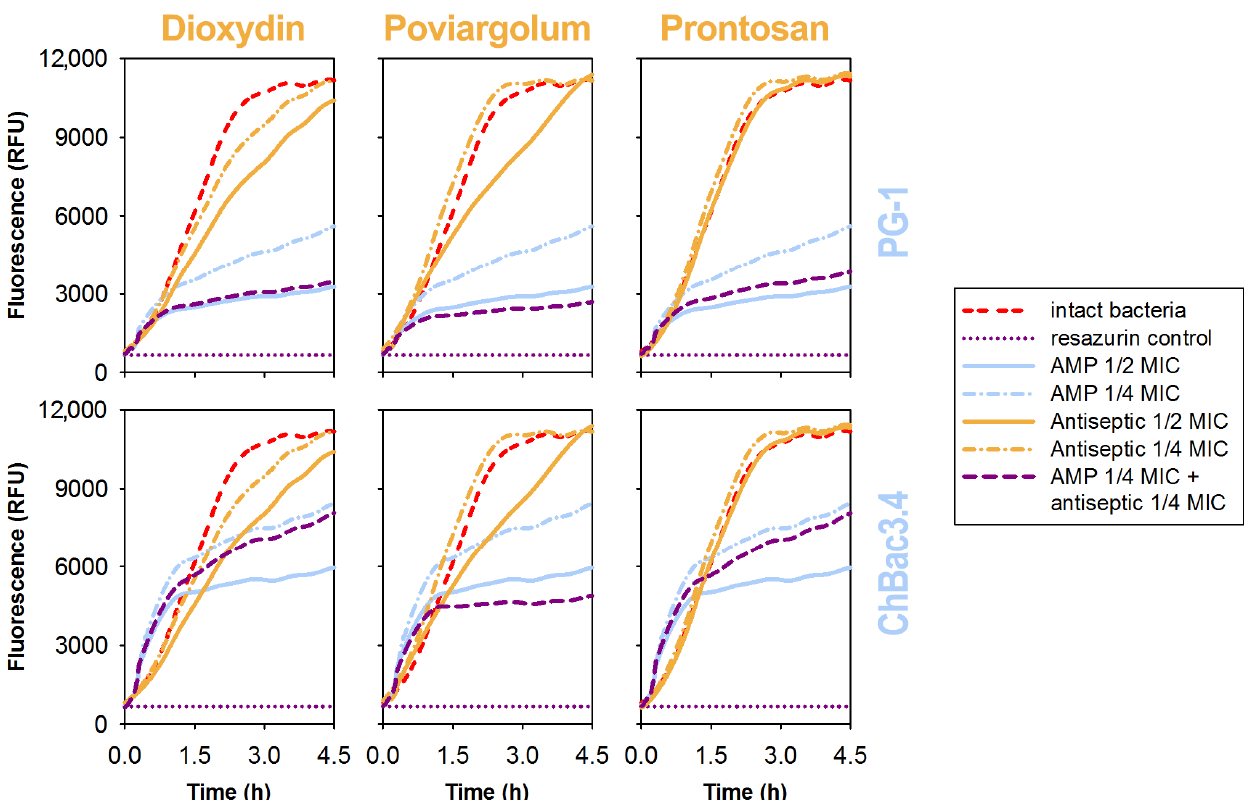
Figure 2. Dynamics of E. coli ML-35p metabolic activity inhibition by the combinations of AMPs with antiseptics and surfactants. Individual action of 1 / 4 and 1 / 2 of minimal inhibitory concentrations (MICs) of compounds is compared to that of their combinations containing 1 / 4 MIC of AMP + 1 / 4 MIC of antibiotic/surfactant. An increase in fluorescence intensity indicates actively metabolizing bacteria in which redox-sensitive marker resazurin is continuously reduced into fluorescent resorufin. The quicker the plateau is reached and the lower its level is compared with the control of intact bacteria, the stronger and faster is the antimicrobial effect that it